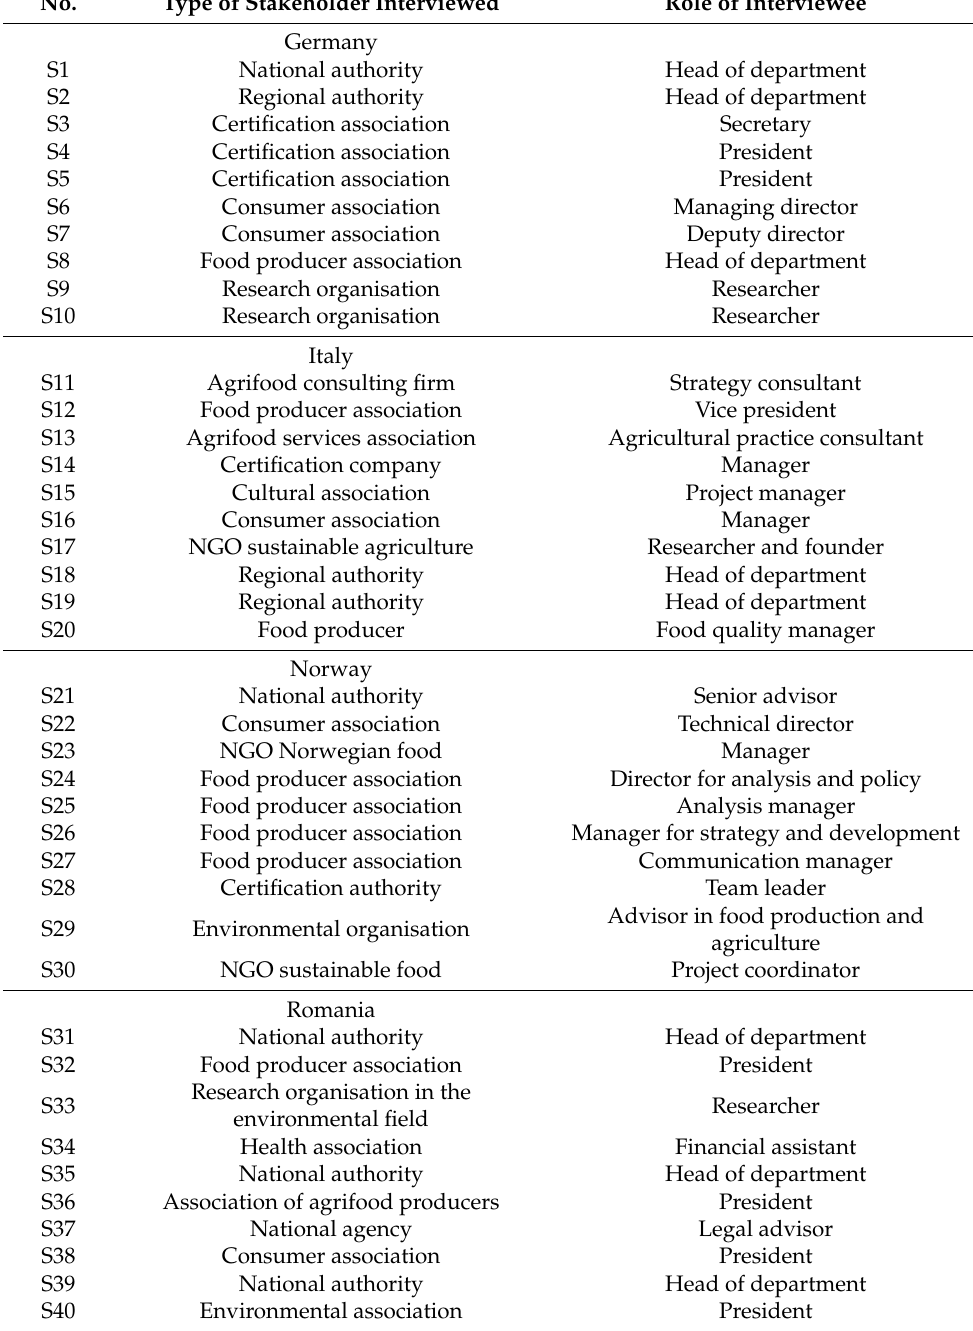
Table 2. Informant type interviewed by